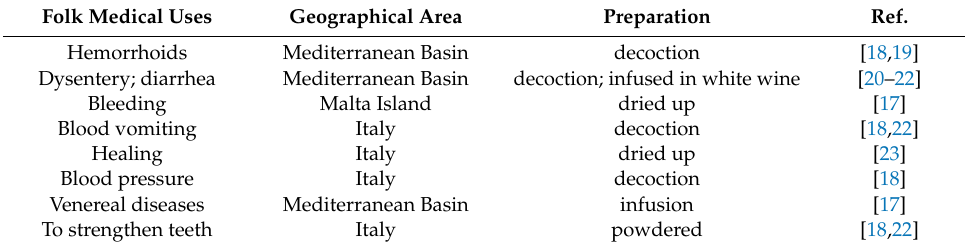
Table 1. Some ancient uses of C. coccineum aerial part in folk medicine.